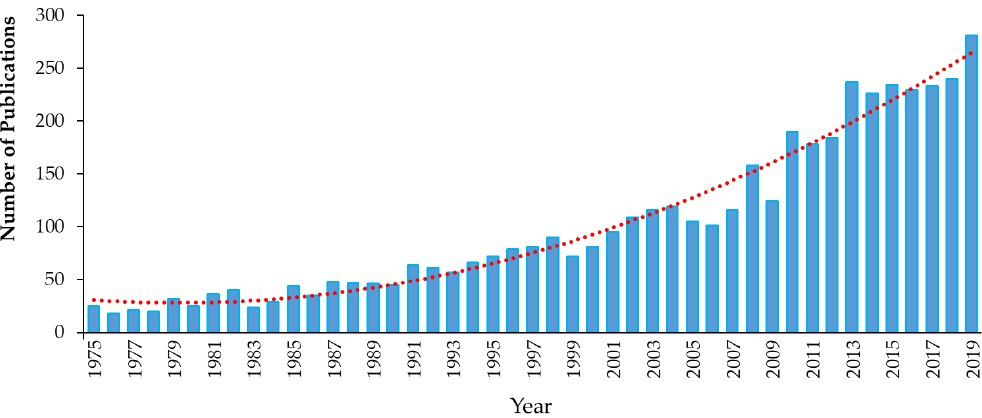
Figure 7. Number of scientific documents on the topic of “benzalkonium chloride” published for the time period from 1975 to 2019 (data generated from reference [74]).